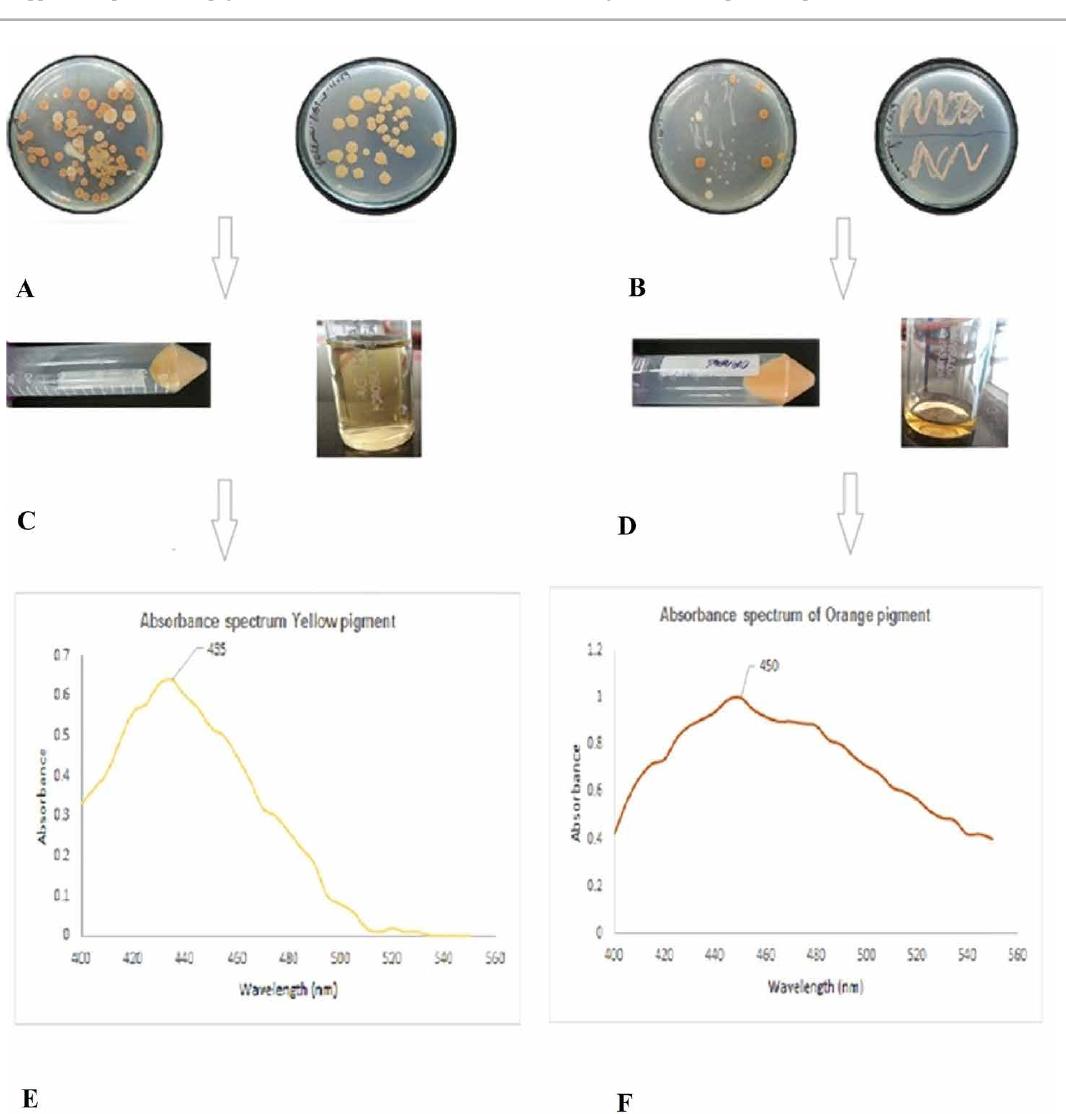
FIGURE 1 – Isolate plates P1 (A) and P3 (B); pellets and methanol extracts of the carotenoid pigments of P1 (C) and P3 (D); absorption spectra of pigments extracted from P1 (E) and P3 (F).